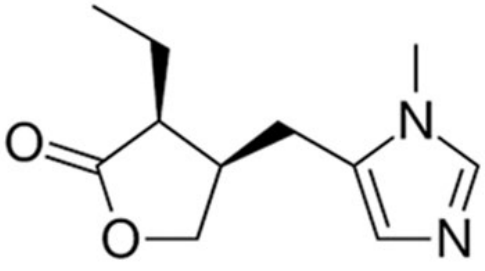
Figure 2. Chemical structure of pilocarpine base.